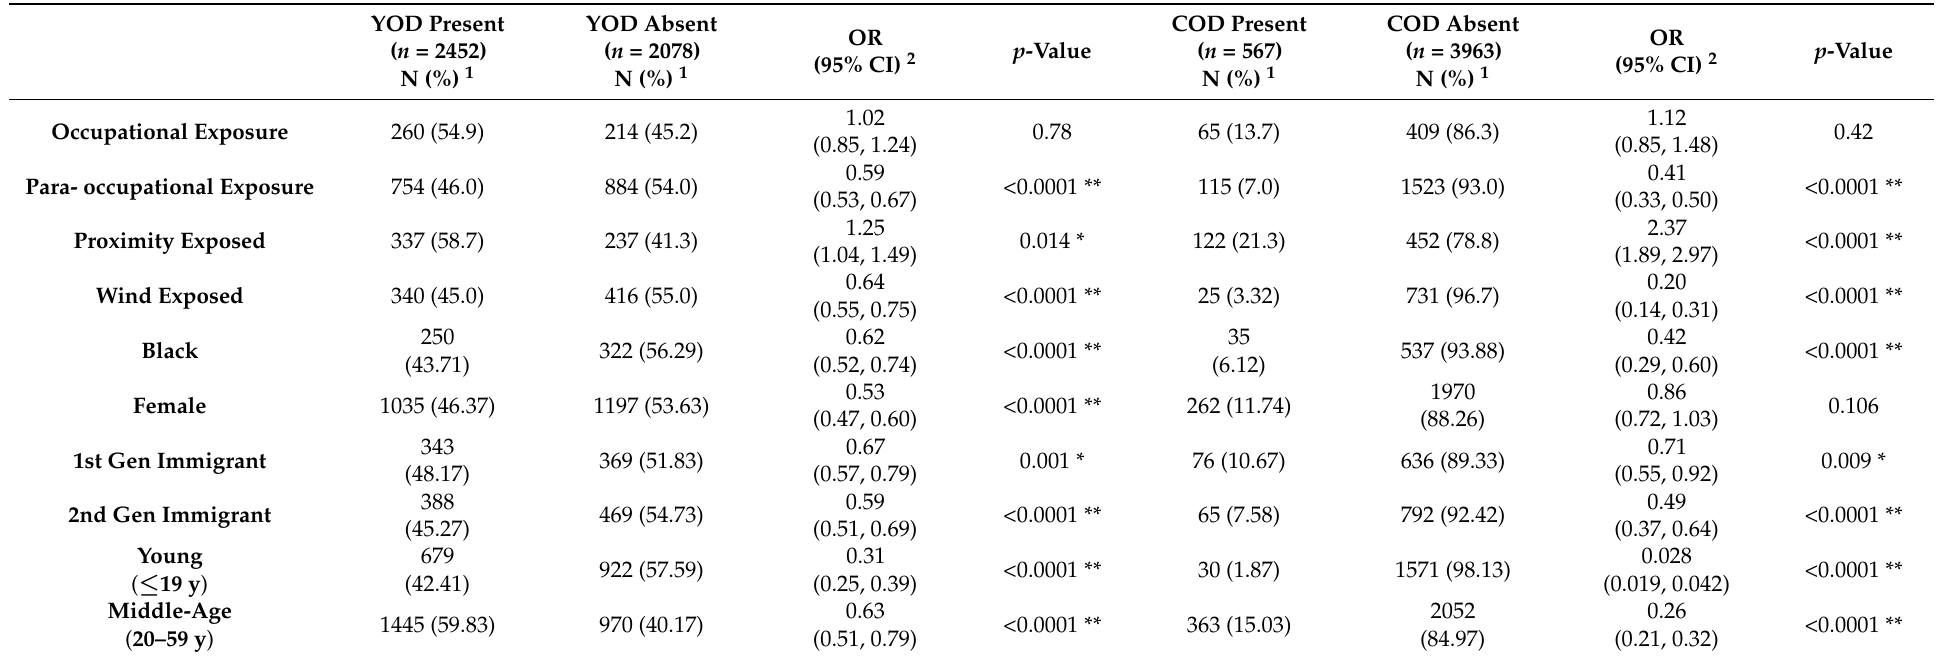
Table 4 Legend: Death data obtained included year of death (YOD) and cause of death (COD). Data collected for 1st and 2nd generation immigrants were compared to the data obtained for non-immigrants, and young and middle-aged individuals were compared to the data available for older cohort members (>60 y). ( 1 ) Chi-squared contingency; Test, ( 2 ) Logistic regression analysis; (**) for p -value < 0.0001; (*) for p -value <